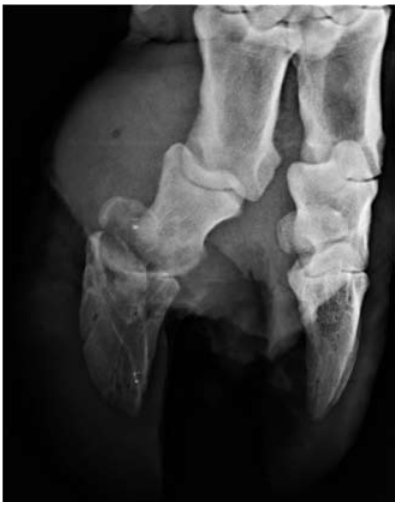
Fig. 5. Fracture of 3 rd Phalanx Fig.6. P3